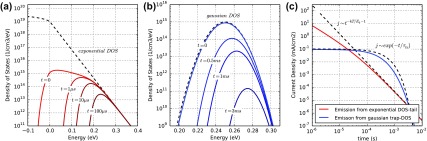
Calculation of the thermal emission of charge carriers from the density of states. (a) The dashed line is the density of states with square-root dependence above the band edge and exponential dependence inside the band. The solid lines represent the charge carrier distributions at different times. The LUMO-level is located at 0 eV, positive energy values reach into the band-gap. (b) Same as in (a) but for a Gaussian DOS. (c) Calculated currents from carrier emission of (a) and (b) including analytical fits according to Equations (14) and (16).